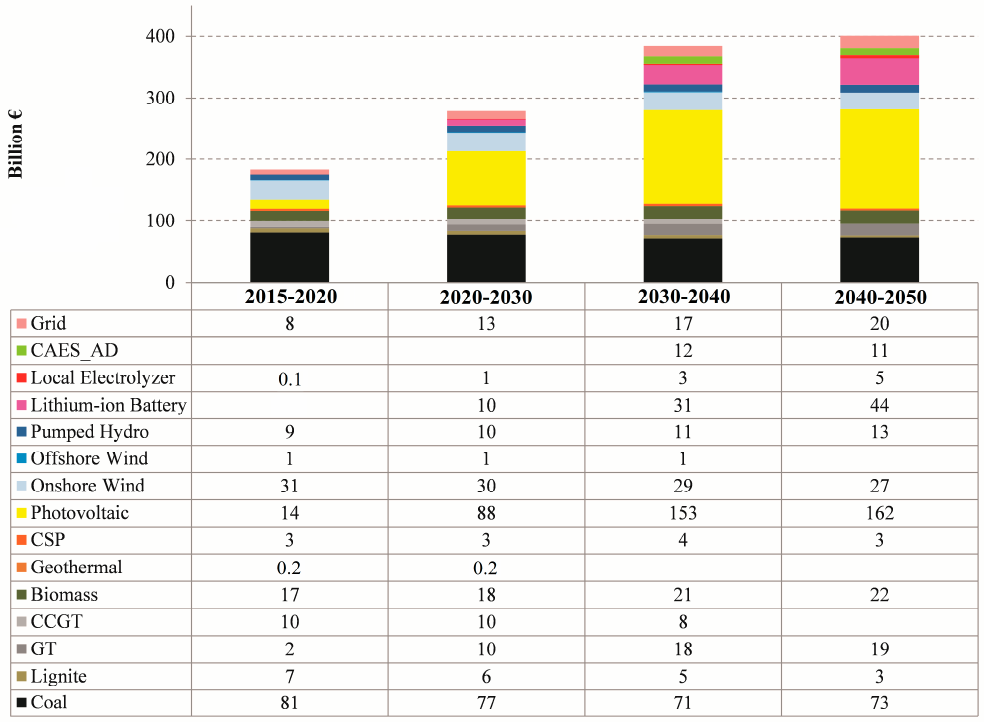
Figure 9. Investments in total installed capacities by technology in the BTH metropolitan region.